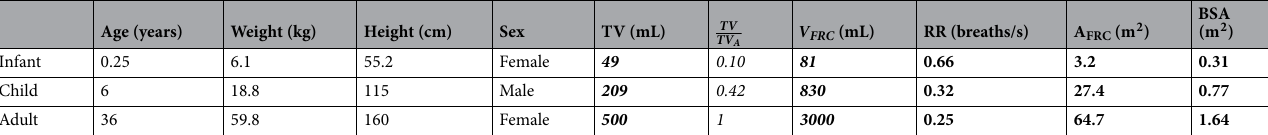
Table 1. Subject demographics and estimated 36,37 (in bold) or calculated (in italicized bold)